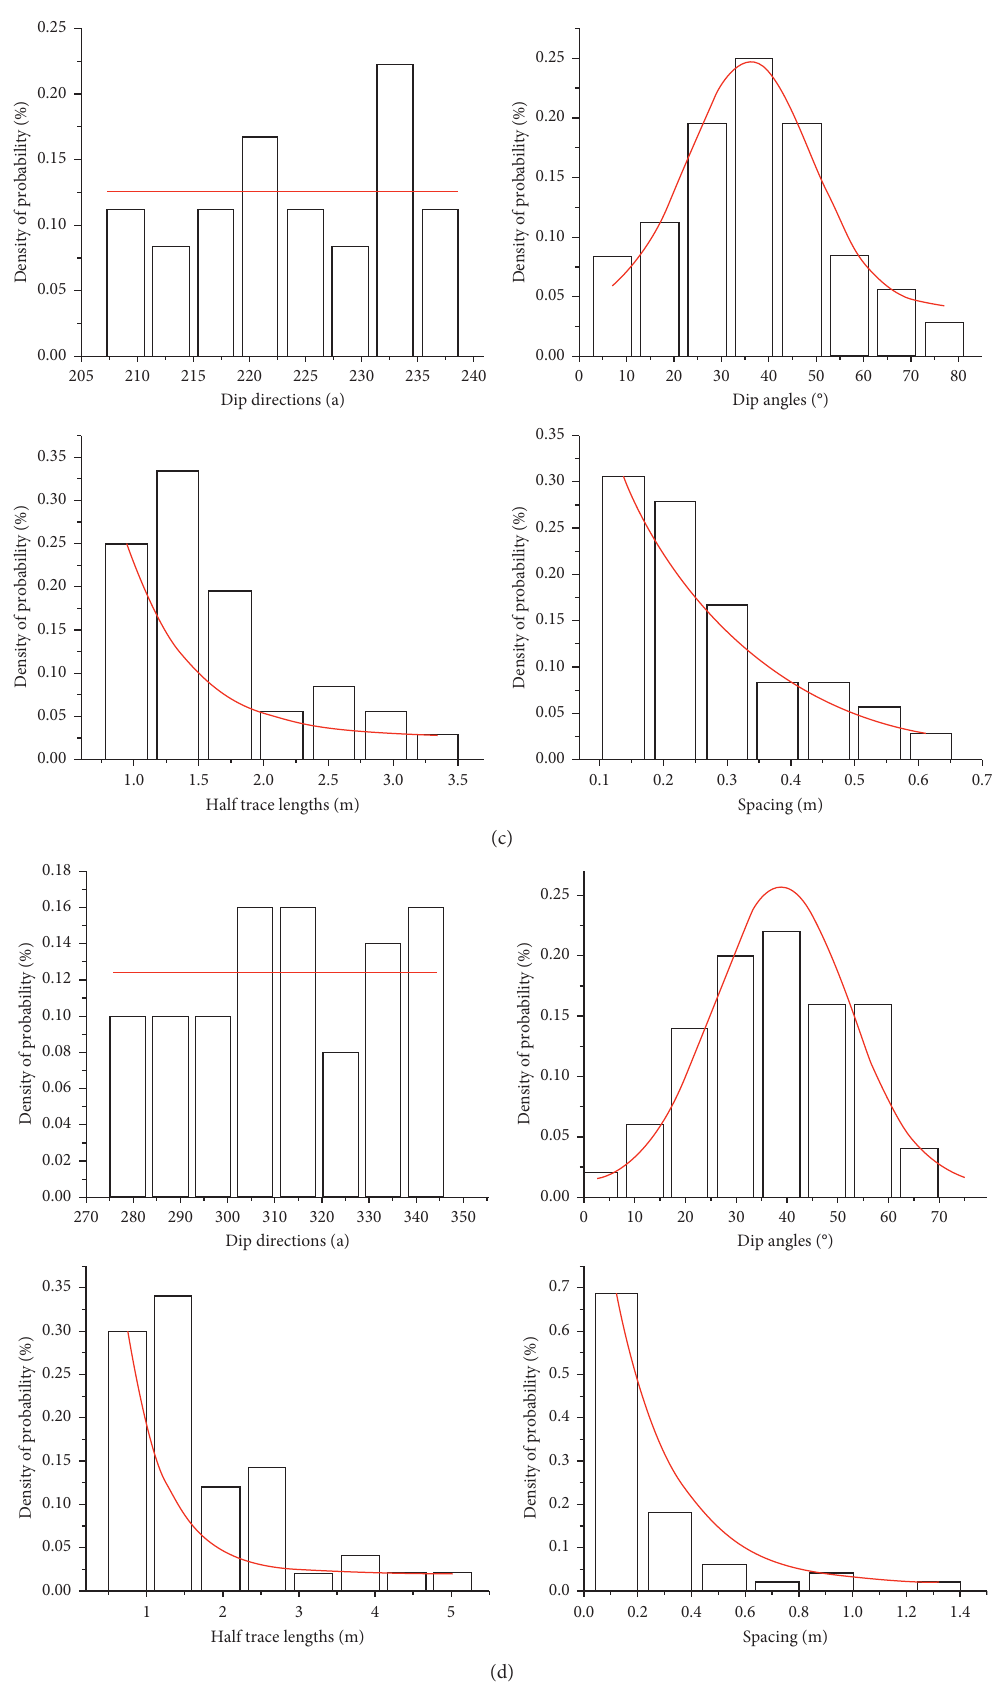
Figure 5: Histogram and probability density: (a) group A; (b) group B; (c) group C; (d) group